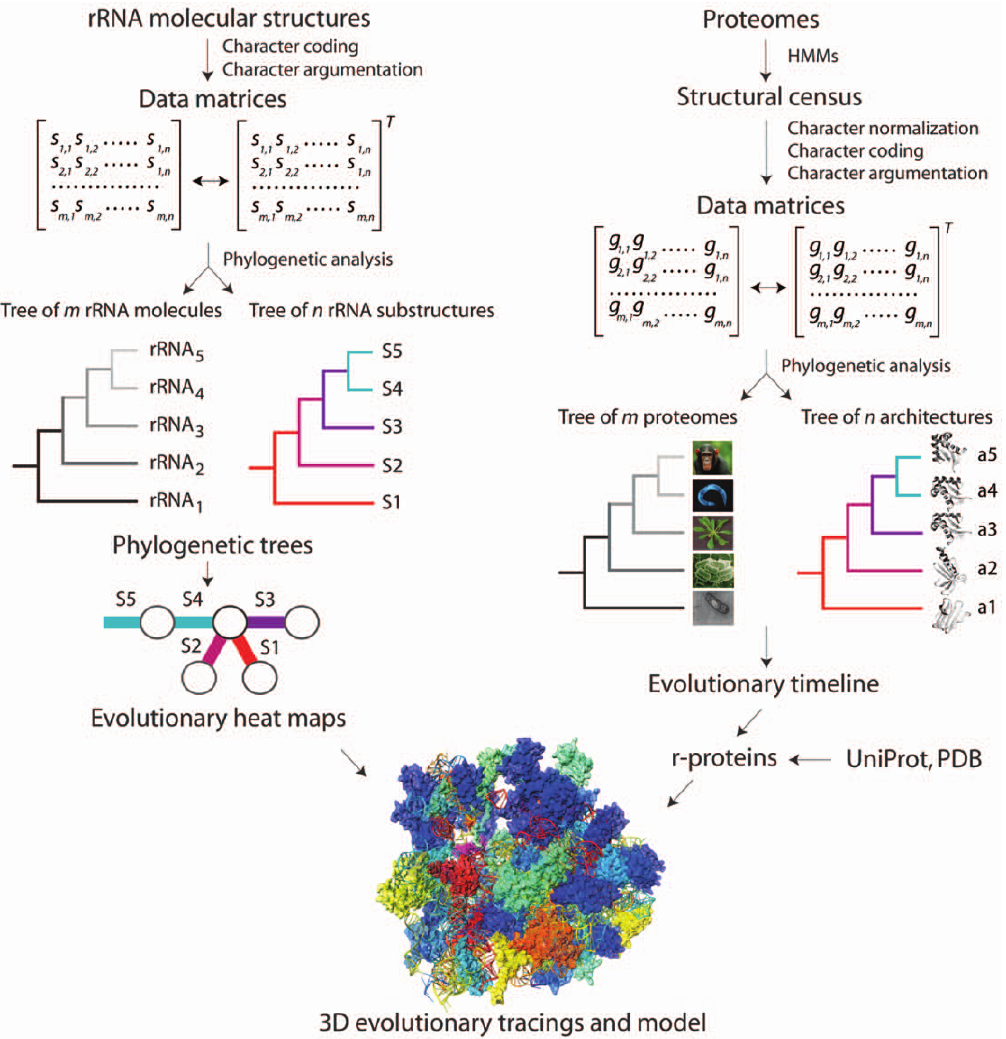
Figure 1. Experimental strategy. The flow diagram in the left describes the phylogenetic reconstruction of trees of rRNA molecules and substructures. The structures of rRNA molecules were first decomposed into substructures, including helical stem tracts and unpaired regions. Structural features of these substructures (e.g., length) were coded as phylogenetic characters and assigned character states according to an evolutionary model that polarizes character transformation towards an increase in molecular order (character argumentation). Coded characters (s) are arranged in data matrices, which can be transposed for cladistic analyses. Phylogenetic analysis using MP methods generate rooted phylogenetic trees of either molecules or substructures. Only trees of substructures are presented in this study. The flow diagram in the right shows the reconstruction of trees of proteomes and trees of protein domain structures. A census of domain structures in proteomes of hundreds of completely sequenced organisms is used to compose a data matrix and its transposed matrix, which are then used to build phylogenomic trees describing the evolution of individual protein structures and entire molecular repertoires, respectively. Elements of the matrix (g) represent genomic abundances of architectures (at FSF level of hierarchical classification of structure) in proteomes. Trees of proteomes will be described elsewhere, but are largely congruent with traditional classification. Embedded in the tree of rRNA substructures and tree of protein domains are timelines that assign age to molecular structures. These ages can be ‘‘painted’’ onto 2D or 3D structural models of the ribosome, generating evolutionary heat maps. Evolutionary information from RNA and protein structures is finally combined to generate a model of structural evolution.